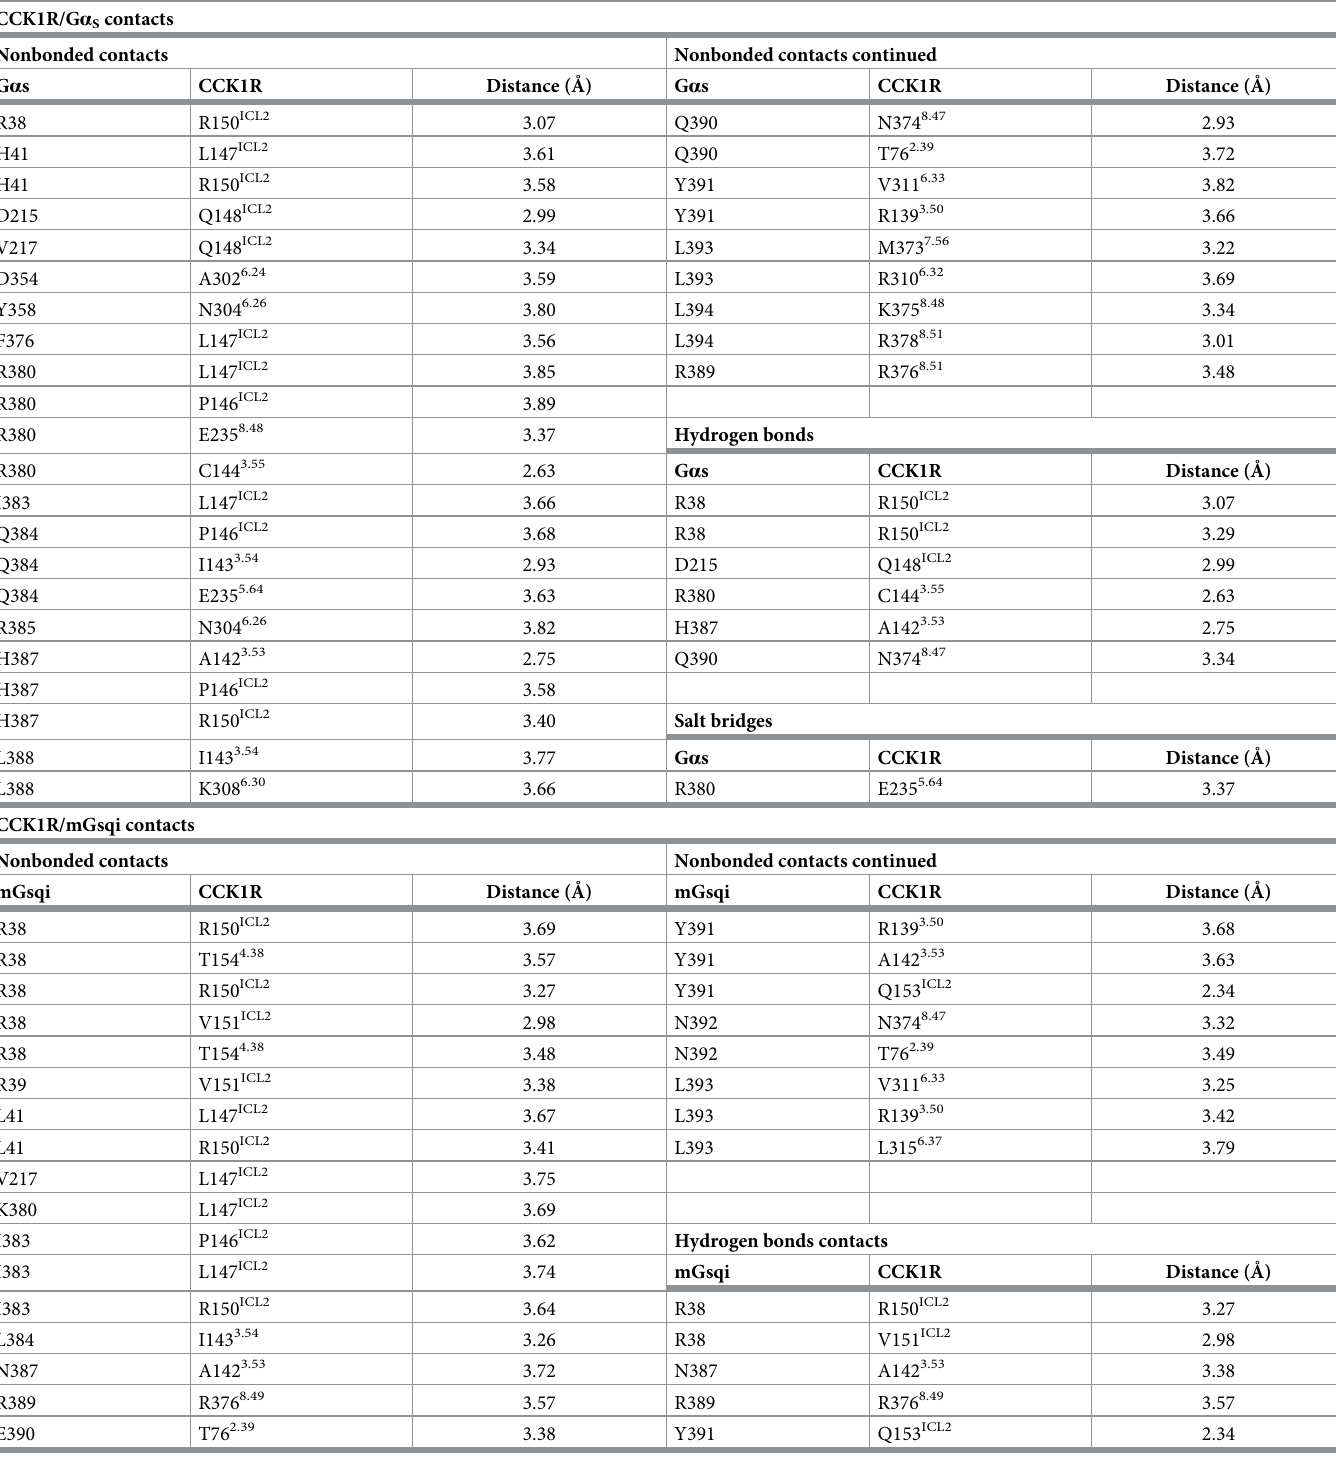
Table 2. List of contacts between CCK1R and G